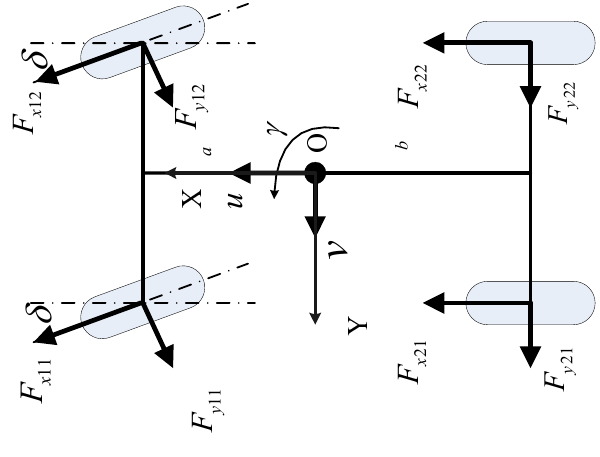
Figure 2. Vehicle dynamic